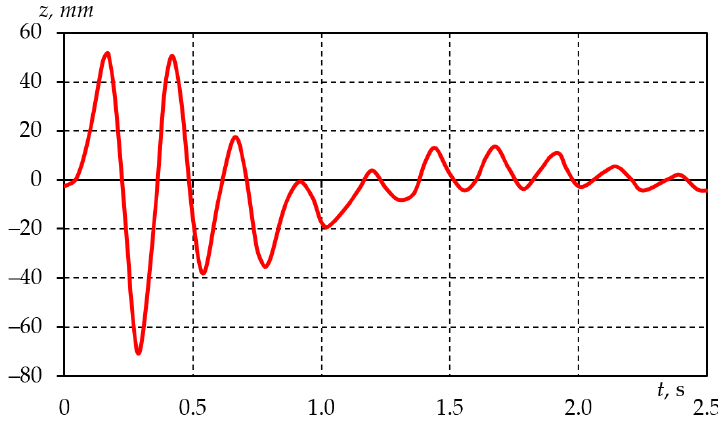
Figure 15. The characteristic of the free oscillations of the vehicle suspension was determined on the car suspension test bench.